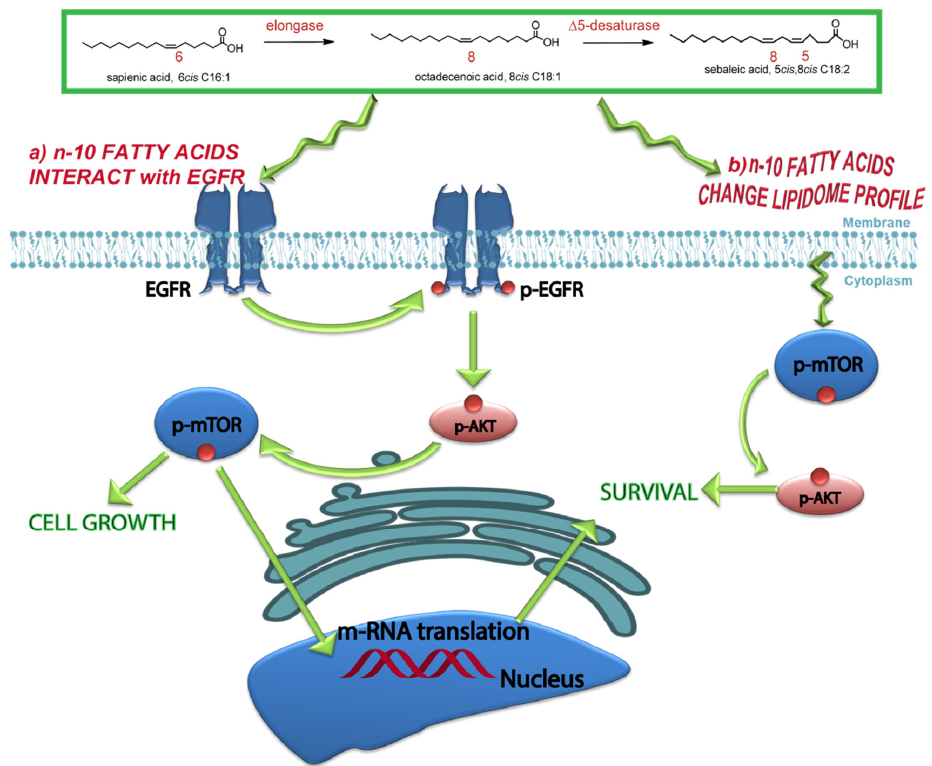
Figure 4. The dual effect of the n-10 fatty acid family in breast cancer cell lines includes ( a ) the direct interaction with EGFR and activation of this pathway (p-EGFR-AKT-mTOR) and ( b ) the insertion of n-10 fatty acids in a membrane lipidome with changes to the membrane properties and activation of signaling (p-mTOR and p-AKT).